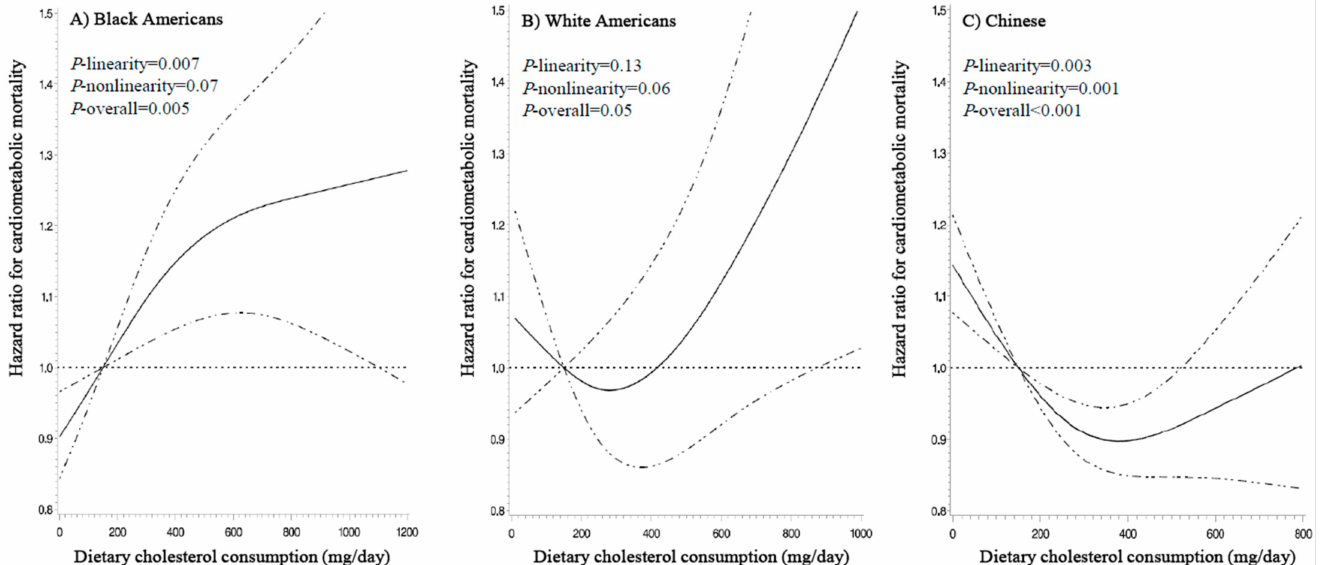
Figure 2. Dose-response relationships of dietary cholesterol intake with cardiometabolic mortality. HRs (solid line) and 95% CIs (dashed line) were adjusted for age, sex, education, annual income, marital status, total energy intake, smoking status, smoking pack-years, alcohol consumption, physical activity level, body mass index, healthy eating index, history of diabetes, hypertension, dyslipidemia, coronary heart disease, and stroke, and hormone replacement therapy (for women only). Intake of refined carbohydrate was further adjusted for in the Chinese population. To minimize the potential effects of extreme values, participants with the top 1% of cholesterol intake were excluded from the analysis; 150 mg/day was set as the reference, and three knot positions were fitted at the 5th, 50th, and 95th percentiles. P -nonlinearity for cardiometabolic mortality were 0.07, 0.06, and 0.001, respectively. Abbreviations: CI, confidence interval; HR, hazard